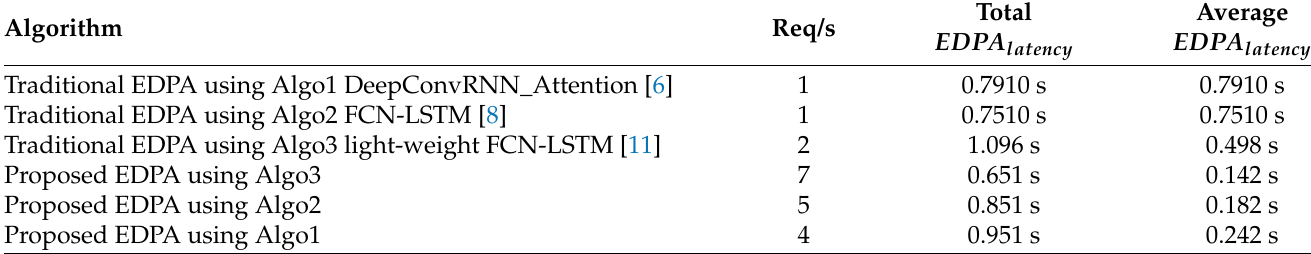
Table 5. End-to-end latency and the number of requests per second (Req/s).